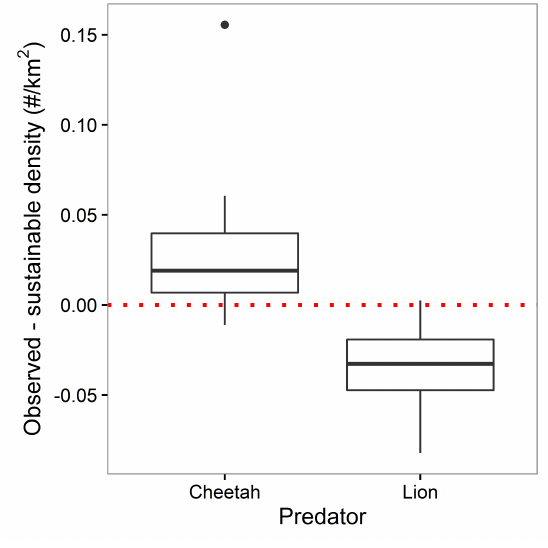
Fig. 5 . Summary statistics across private land conservation areas (PLCAs) that stocked free-roaming cheetah and lion, of the difference between the observed predator density on a PLCA and the density of predators that can be sustainably supported on that PLCA. Lines, boxes, error bars, and circles show medians, interquartile ranges, minima, and maxima (excluding outliers), and outliers (that deviate from the median by > 1 x the interquartile range), respectively. The dashed red line indicates the threshold above which observed predator density is